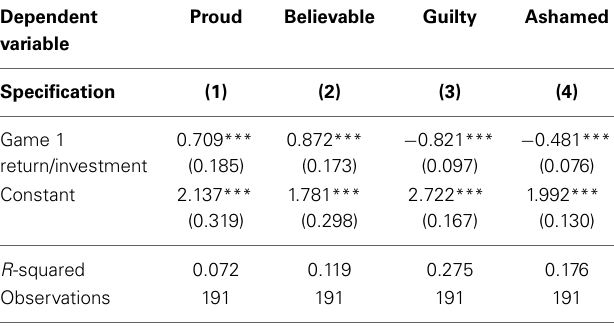
Table 2 | Regression of trustees’ emotions on ROI